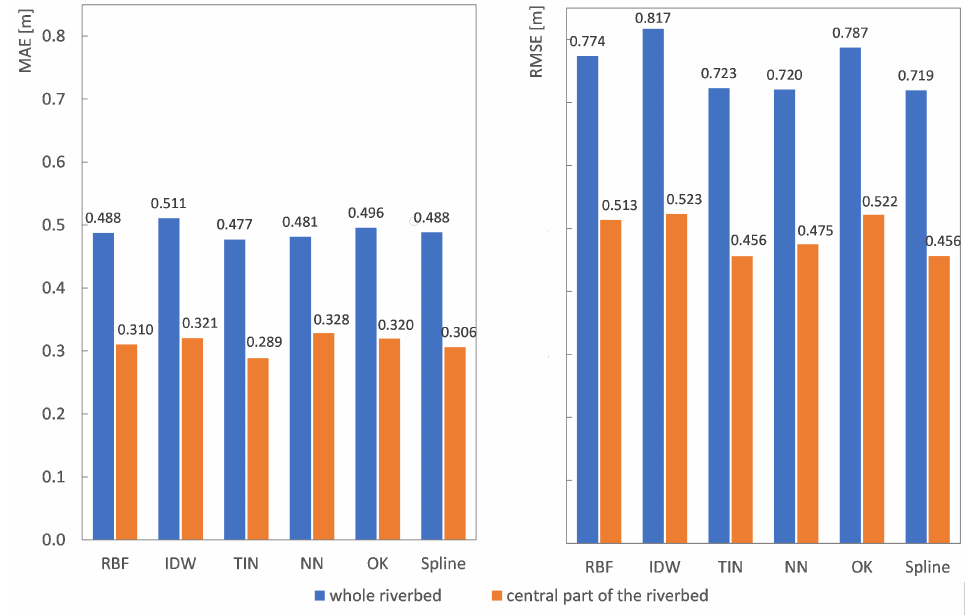
Figure 12. Values of MEA and RMSE [m] estimated for the six interpolation methods.